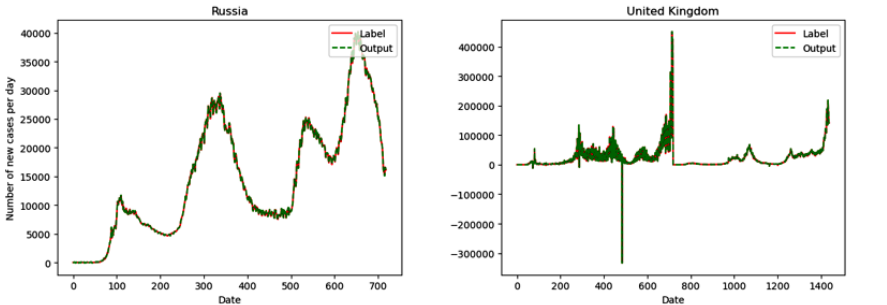
Figure 2. Display of Dual-link BiGRU prediction results.